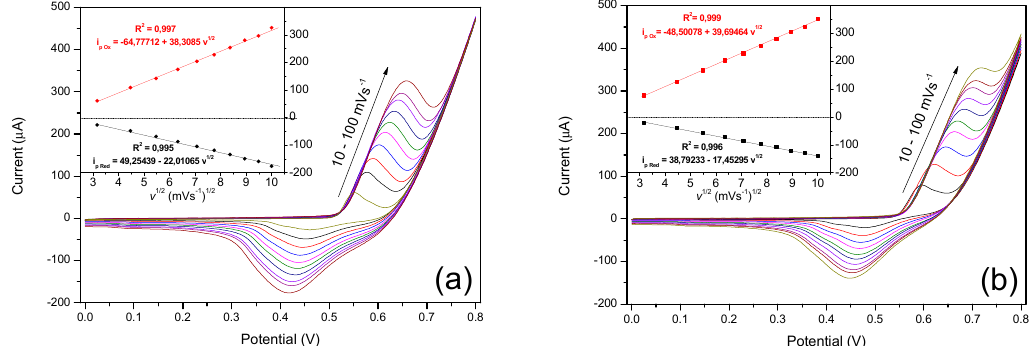
Figure 4. CVs of 20 µL N-CS modified SPCE in the absence ( a ) and presence of 1 mM glucose ( b ) in 0.1 M KOH at different scan rates between 10 and 100 mVs − 1 ; insets: plots of oxidation and reduction peak currents vs square root of scan rate ( v 1/2 ).